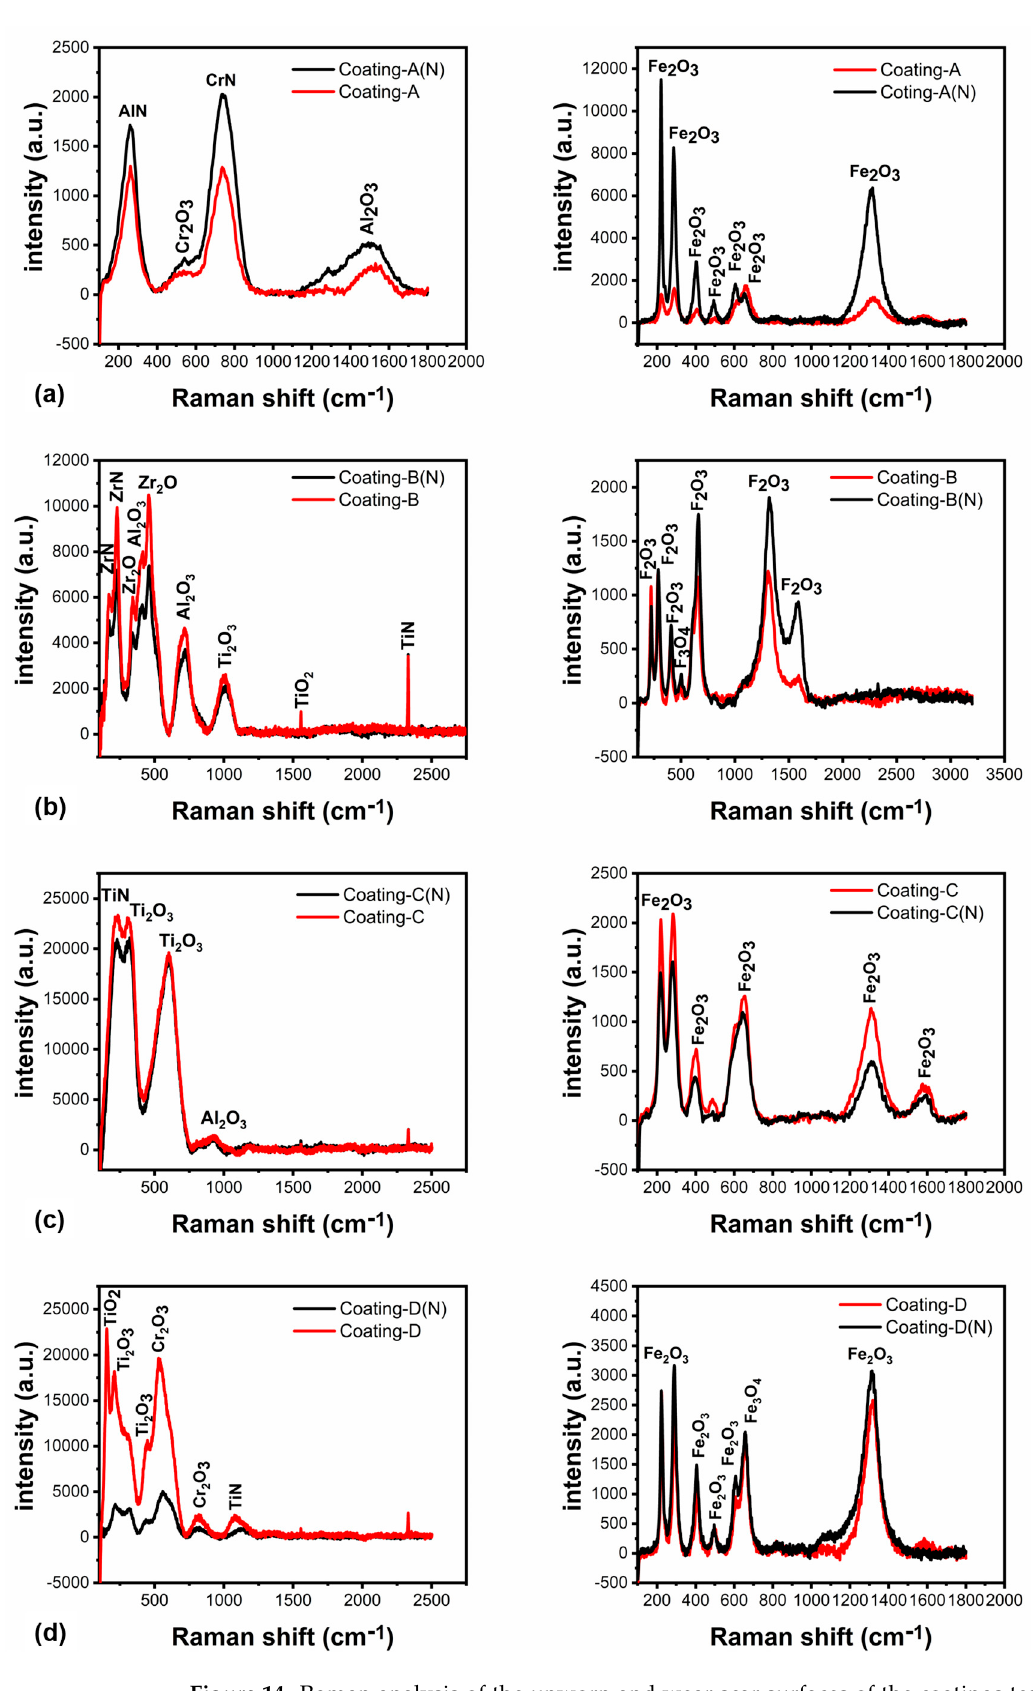
Figure 14. Raman analysis of the unworn and wear scar surfaces of the coatings tested at 700 °C: